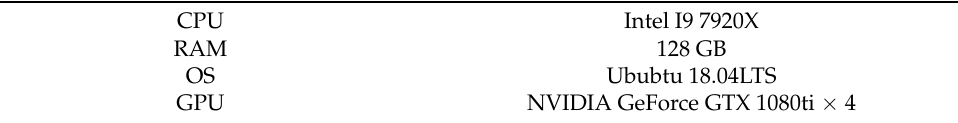
Table 1. Experiment with PC specifications. CPU Intel I9 7920X RAM 128 GB